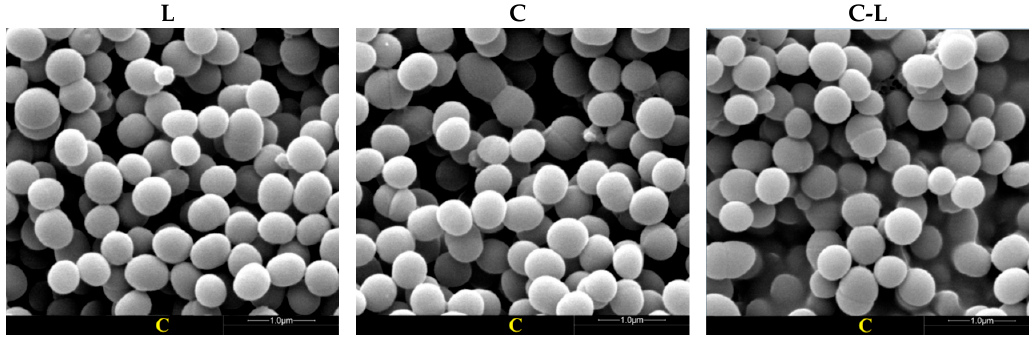
Figure 3. Cont. Figure 3. Cont.